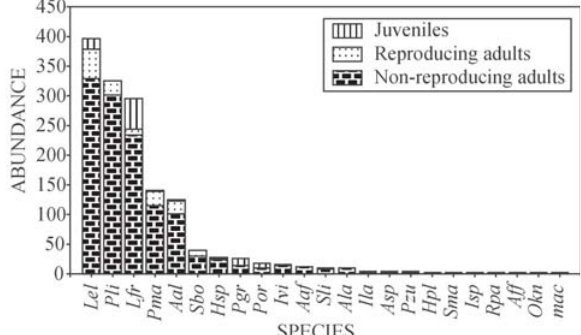
Fig. 2. Abundance of the main middle- and large-sized spe- cies of fish captured in the samples taken in the experimental fish ladder located near Itaipu Dam. The first three letters of each species (found in text) are